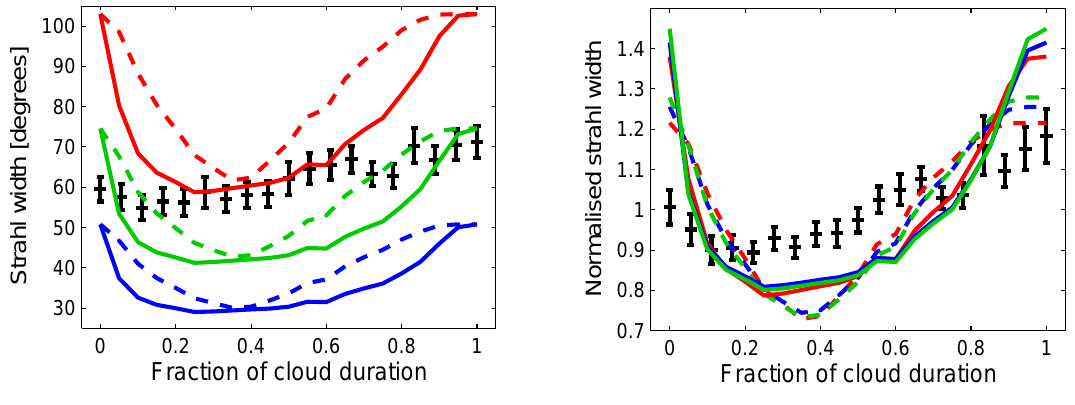
Fig. 8. A superposed epoch plot of the strahl widths in all 74 magnetic clouds catalogued by Cane and Richardson (2003) between 1998 and 2007. Coloured lines show the model predictions in the same format as Fig. 4. In the right panel there is some evidence of the predicted trend in the normalized strahl width